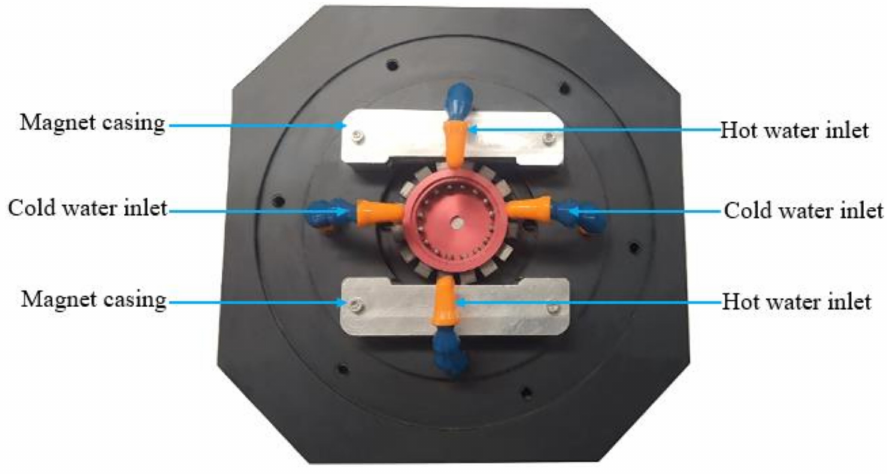
Figure 14. Operational prototype of the optimized model of thermomagnetic